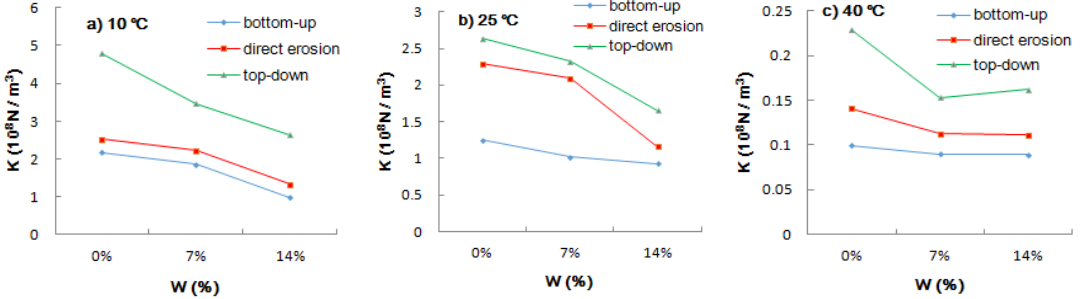
Figure 5. E ff ect of water and salt entry mode on interlaminar shear modulus: ( a ) 10 ◦ C; ( b ) 25 ◦ C; Figure 5. Effect of water and salt entry mode on interlaminar shear modulus : ( a ) 10 °C; ( b ) 25 °C; ( c ) ( c ) 40 ◦ 40 °C.